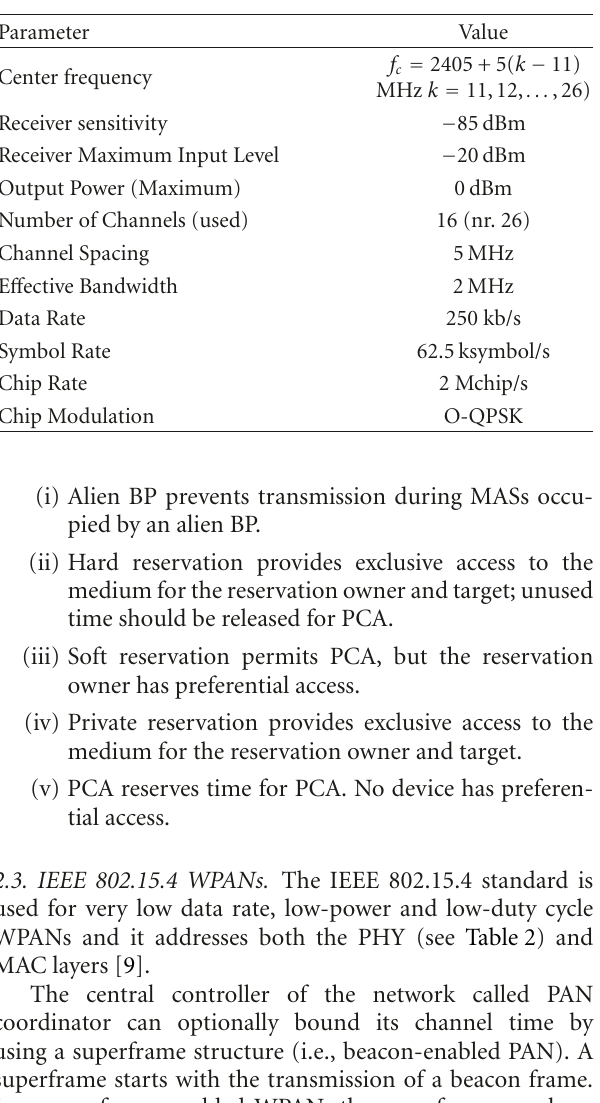
Table 2: Summary of parameters considered for the standard IEEE